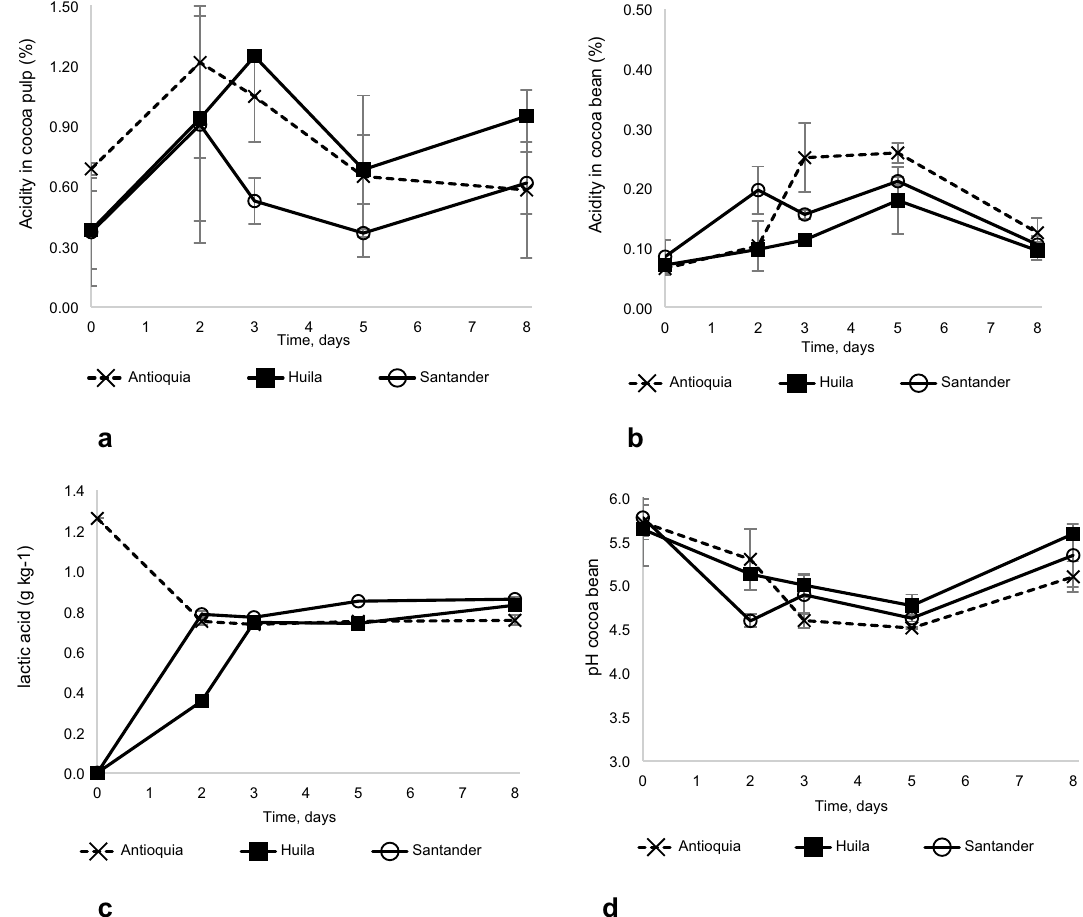
Figure 3. Dynamics of four variables during cocoa fermentation in three locations; Antioquia, Huila and Santander: ( a ) Acidity of the pulp, ( b ) acidity of the bean, ( c ) concentration of lactic acid, and ( d ) pH of the